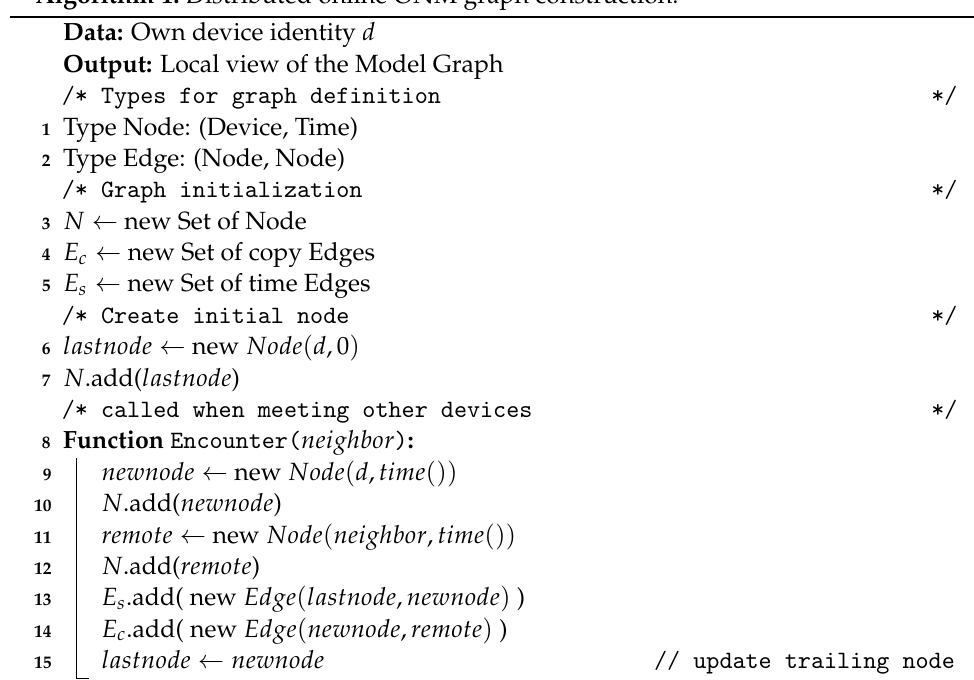
Algorithm 1: Distributed online ONM graph